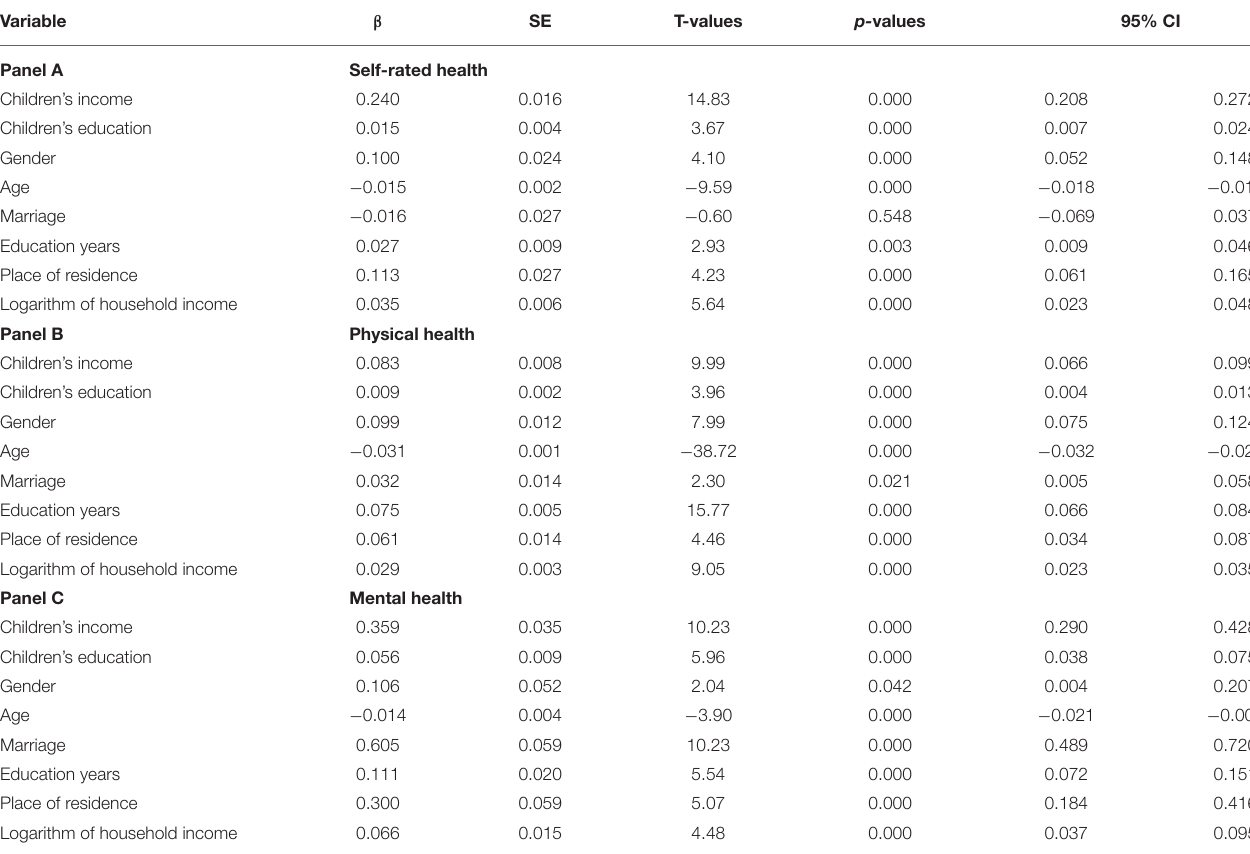
TABLE 3 | Regression results about children’s achievements and elderly health.